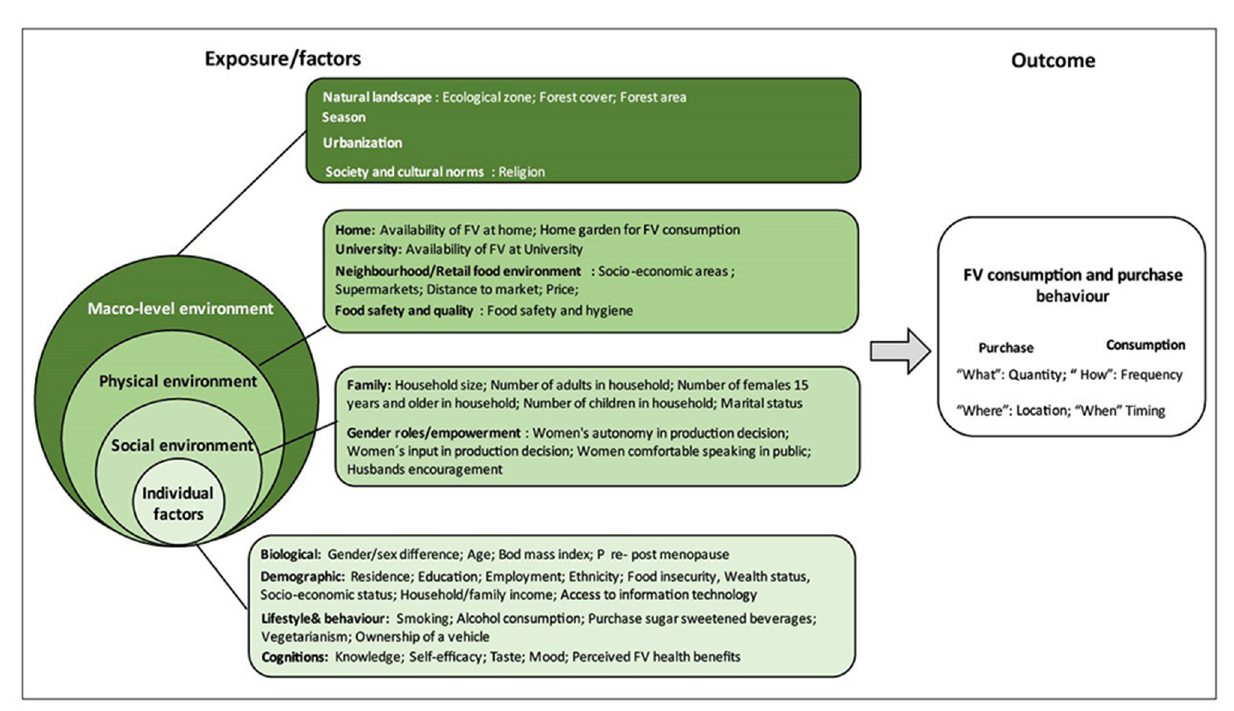
FIGURE3 Conceptual framework based on a socio-ecological framework (12) and its adaptation for LMICs (18, 19) and Africa (11) illustrating identified factors in the review that affect fruit and vegetable consumption and purchase. Exposure/factors represented showed an association with the outcome variable or significant differences in the outcome variable. (ii) Outcome: Most outcome variables refers to FV consumption in terms of quantity (“What”) and frequency